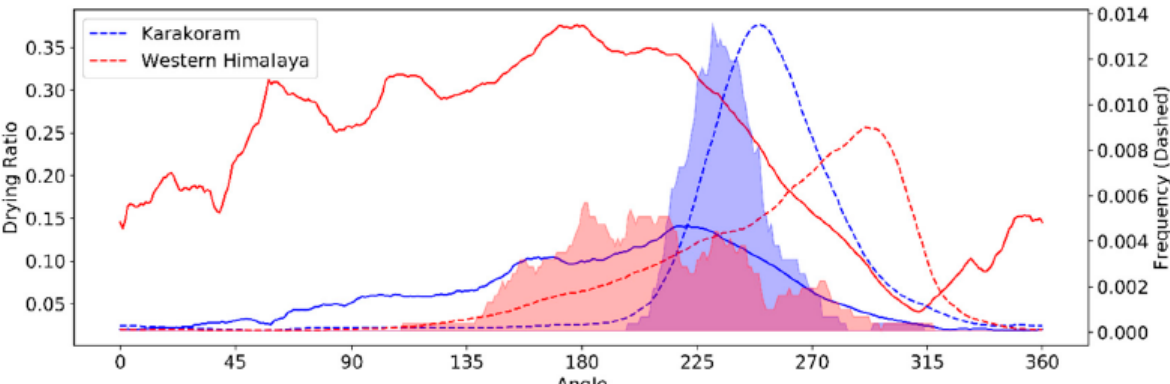
Figure 9. For the Karakoram (blue) and western Himalaya (red), 96-h IVT frequency for the entire 15-year study period (dashed lines), the relative frequency of the largest annual IVT events (top 5 per year, 80 total) (color fill), and drying ratio (solid lines). Bin width for IVT direction is 20 ◦ . The Karakoram and western Himalaya subregions of focus here are outlined as black boxes in Figures 3, 6 and